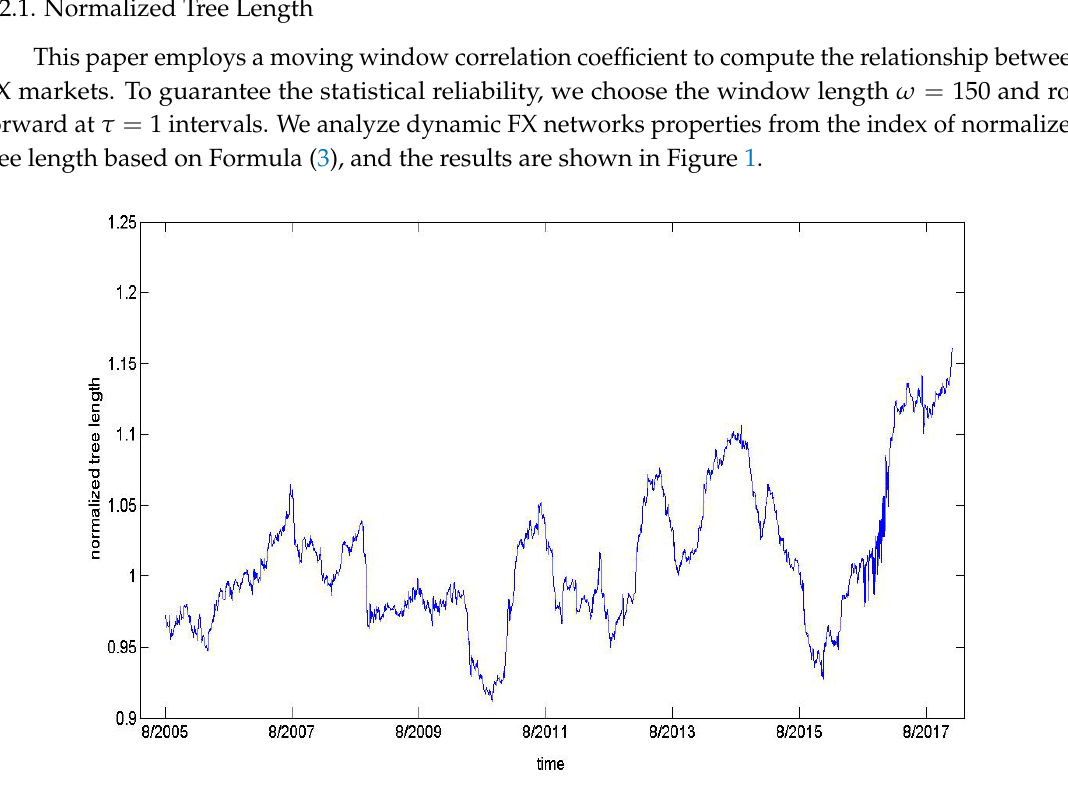
Figure 1. The normalized tree length of the foreign exchange (FX) network in each